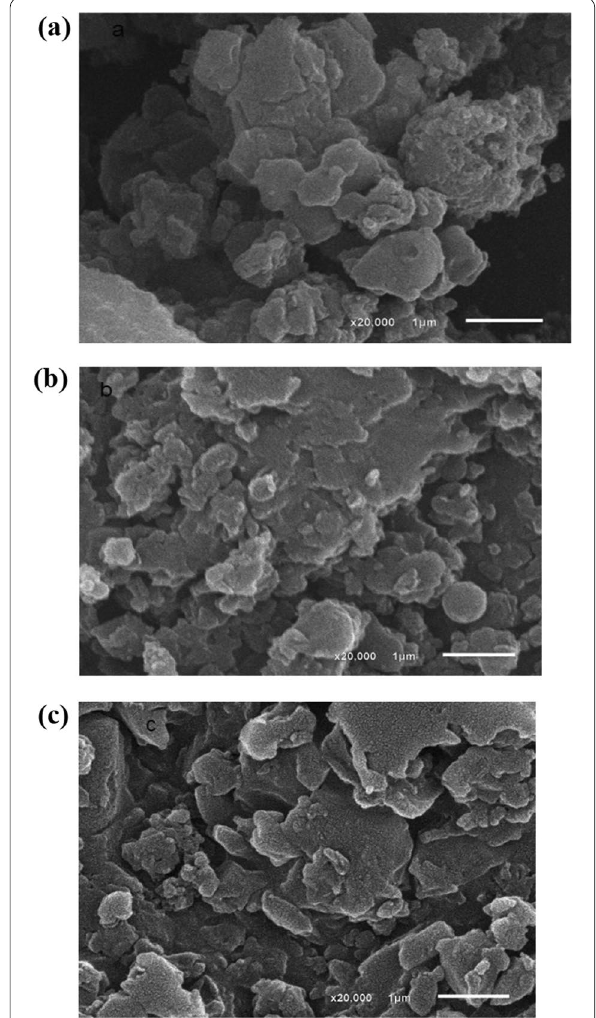
Fig. 3 SEM images of styrene‑acrylamide (14:1) copolymer ( a ), aniline graft ( b ) and 2‑chloroaniline graft ( c